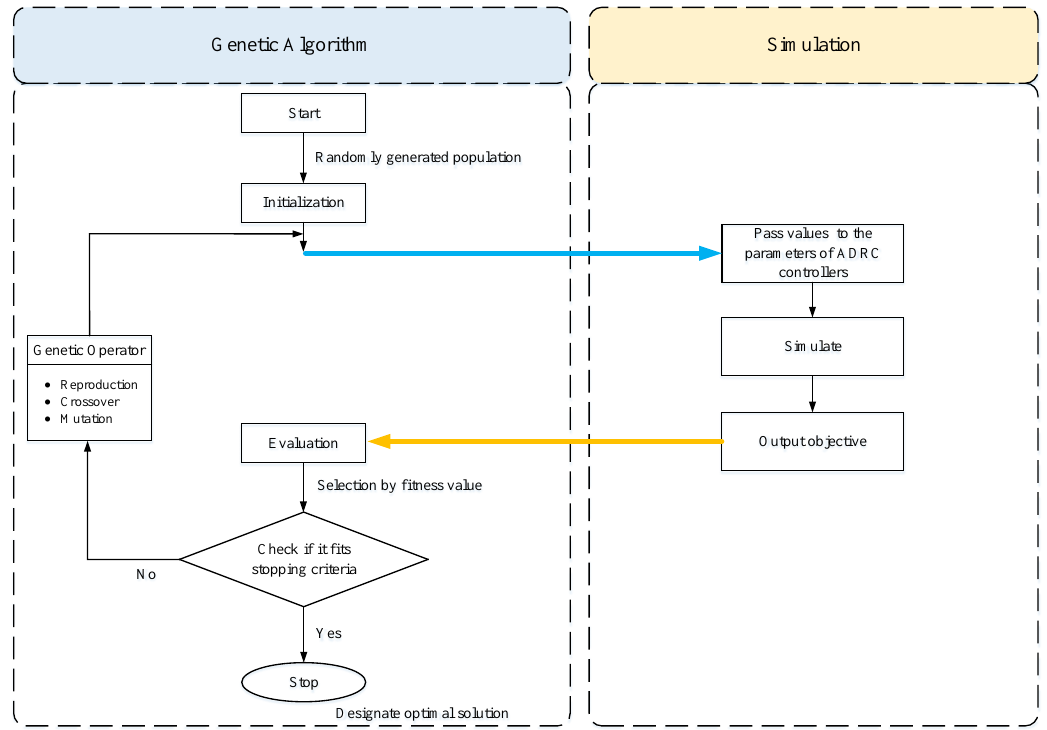
Figure 8. Flowchart of genetic algorithm based ADRC